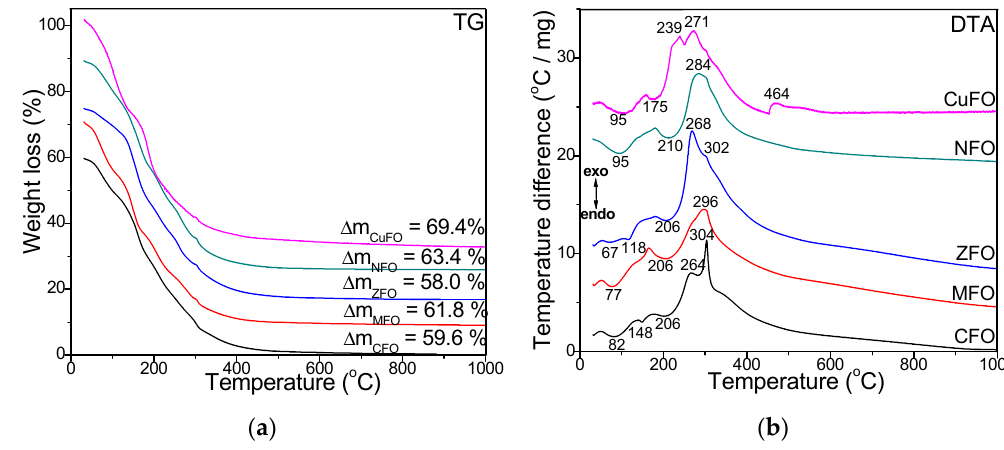
Figure 1. Thermogravimetry (TG) ( a ) and differential thermal analysis (DTA) ( b ) diagrams of cobalt ferrite (CFO), zinc ferrite (ZFO), nickel ferrite (NFO), manganese ferrite (MFO), and copper ferrite (CuFO) samples dried at 40 °C .